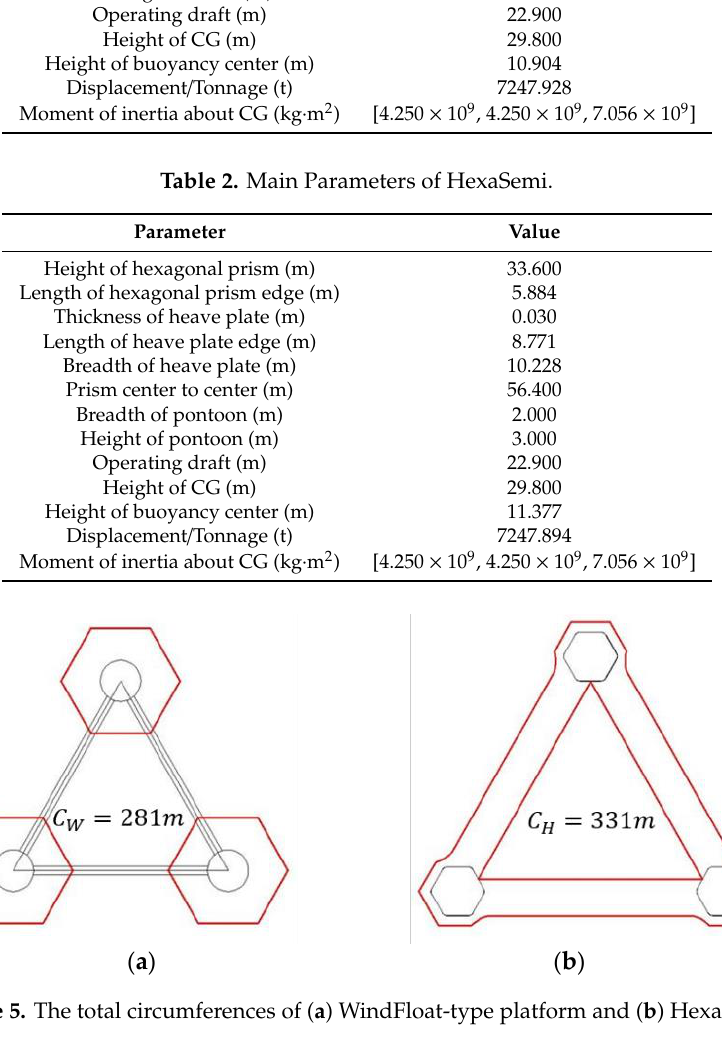
Table 1. Main Parameters of the WindFloat-type platform-type platform.